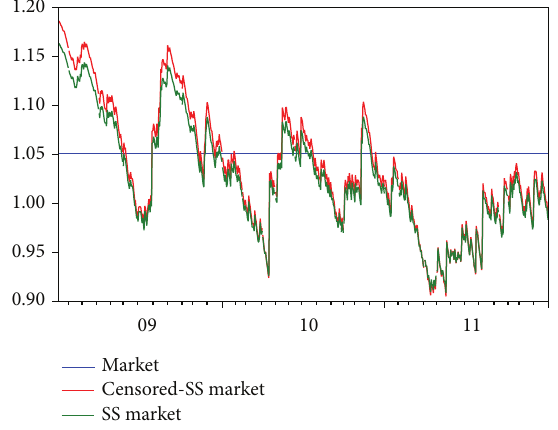
Figure 4: Beta sequences of small corporations combination.